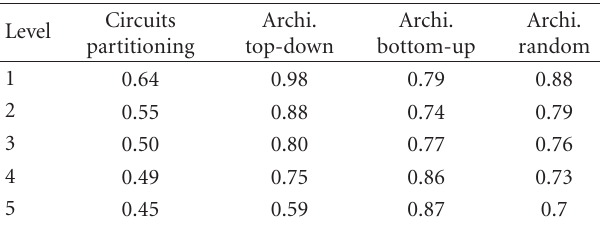
Table 2: Levels Rent’s rule parameters (21 benchmark